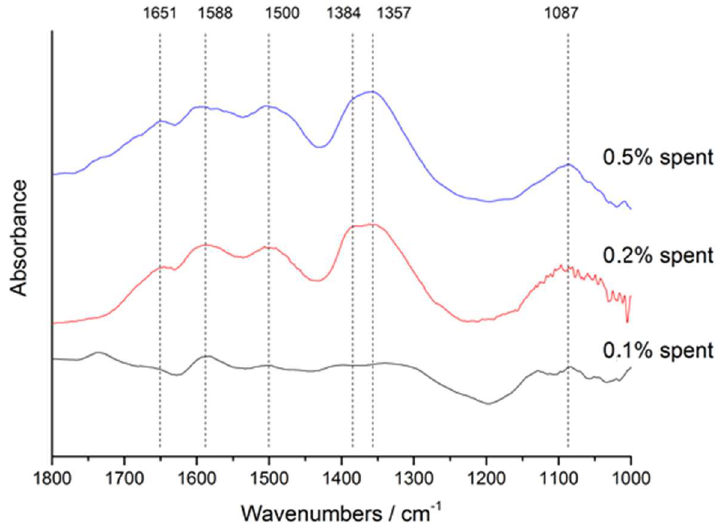
Figure 8. Carbonate IR region obtained after the subtraction of DRIFTS spectra of fresh samples to spent samples.